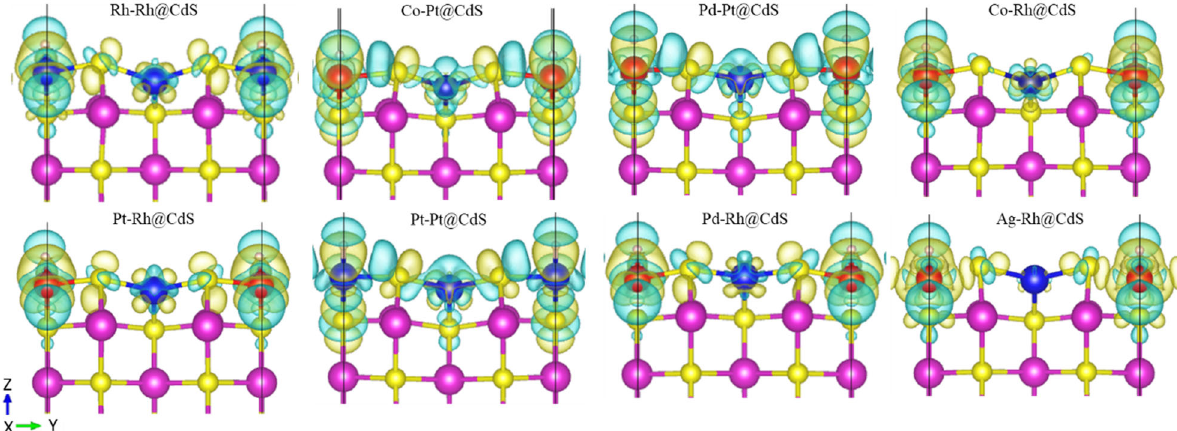
Fig. 10 Charge density difference of the optimized H adsorption on the pristine CdS (110) surface and TM1-TM2@CdS surfaces. Color code TM1 = blue, TM2 = red, the rest as Fig. 8. The order of dopants is the HER